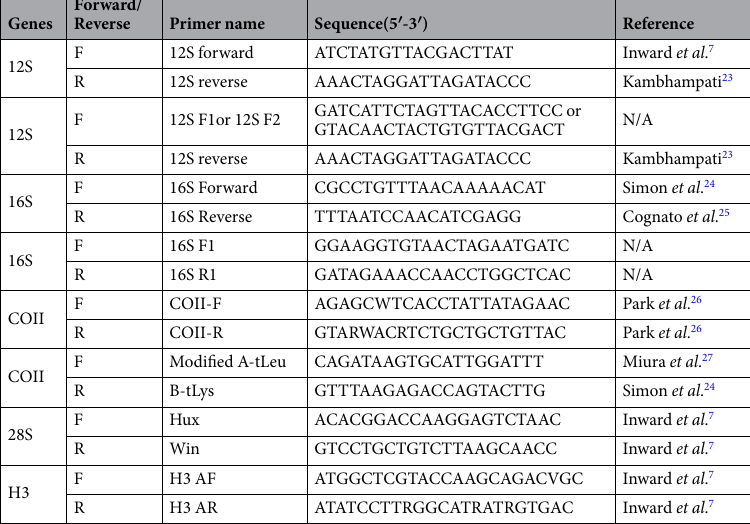
Histone H3. Total DNA was extracted from hindleg tissues of samples preserved in 100% ethanol. The extrac- tion procedure was according to the TIANamp Genomic DNA Kit (Tiangen Biotech, Beijing). Fragments of 12S